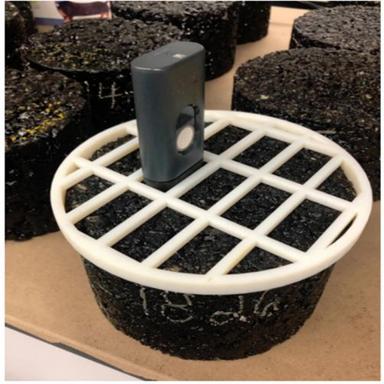
Asphalt mixture samples in MAPIL. Fig. 29. The 3D printed mold used for scanning asphalt mixture samples.